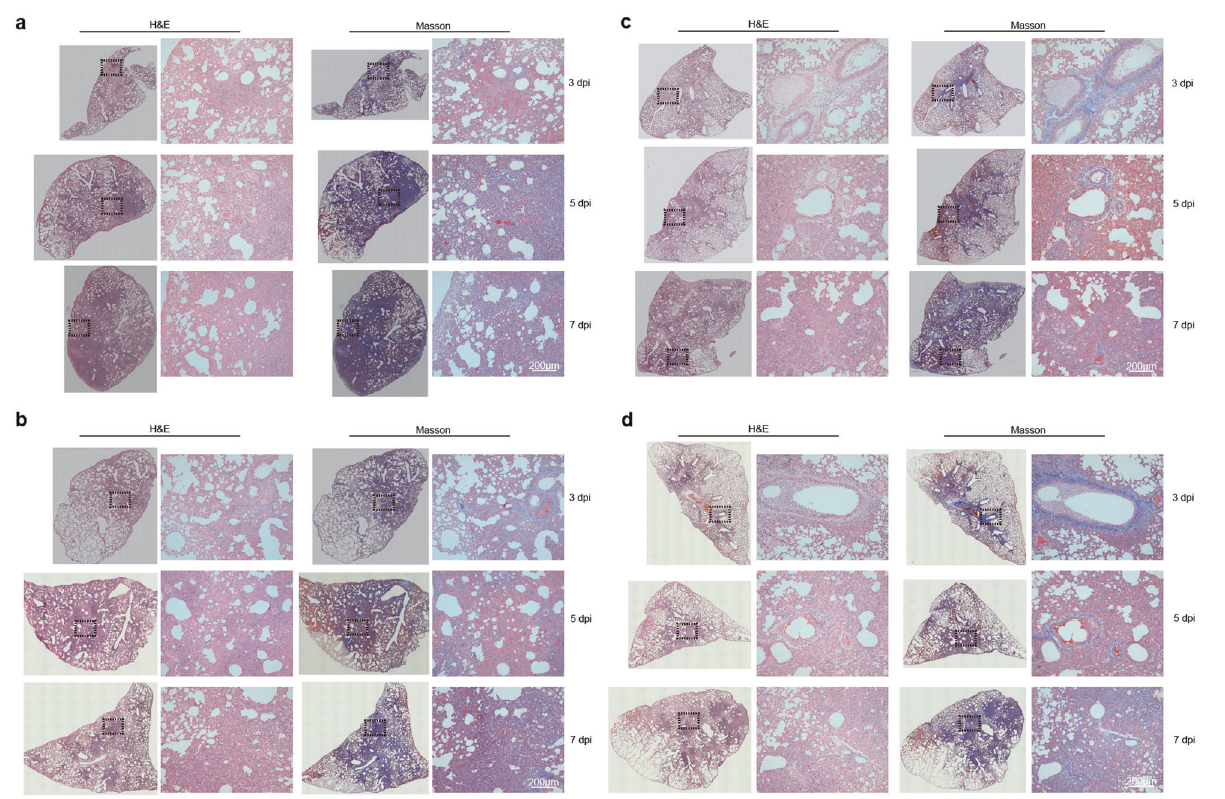
Fig. 4 Pathological analysis of lung pathological lesions of hamsters nasally inoculated with different doses of SARS-CoV-2. H&E staining and Masson staining for representative lung sections collected from male hamsters nasally inoculated without a 1 × 10 2 , b 1 × 10 3 , c 1 × 10 4 , and